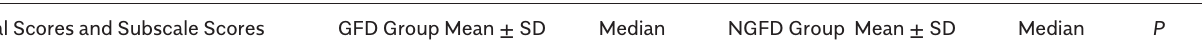
Table 6. CDQ Scores of Groups Total Scores and Subscale Scores